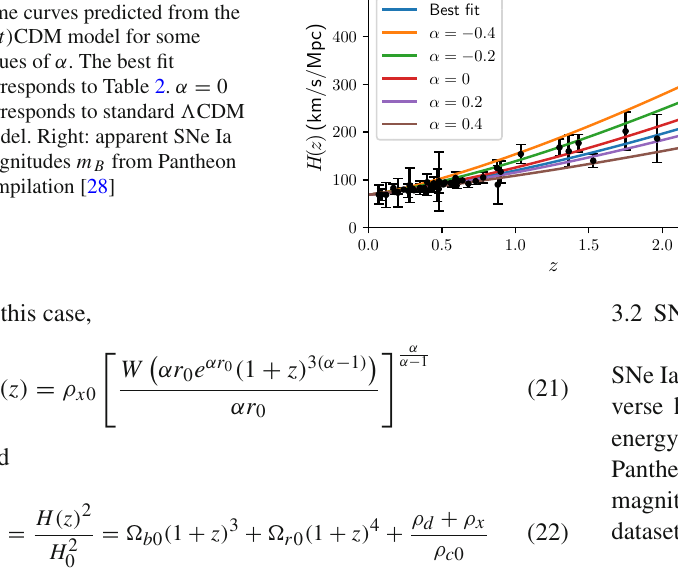
Fig. 2 Left: H ( z ) data [27] and some curves predicted from the (cid:4)( t ) CDM model for some values of α . The best fit corresponds to Table 2. α = 0 corresponds to standard (cid:4) CDM model. Right: apparent SNe Ia magnitudes m B from Pantheon